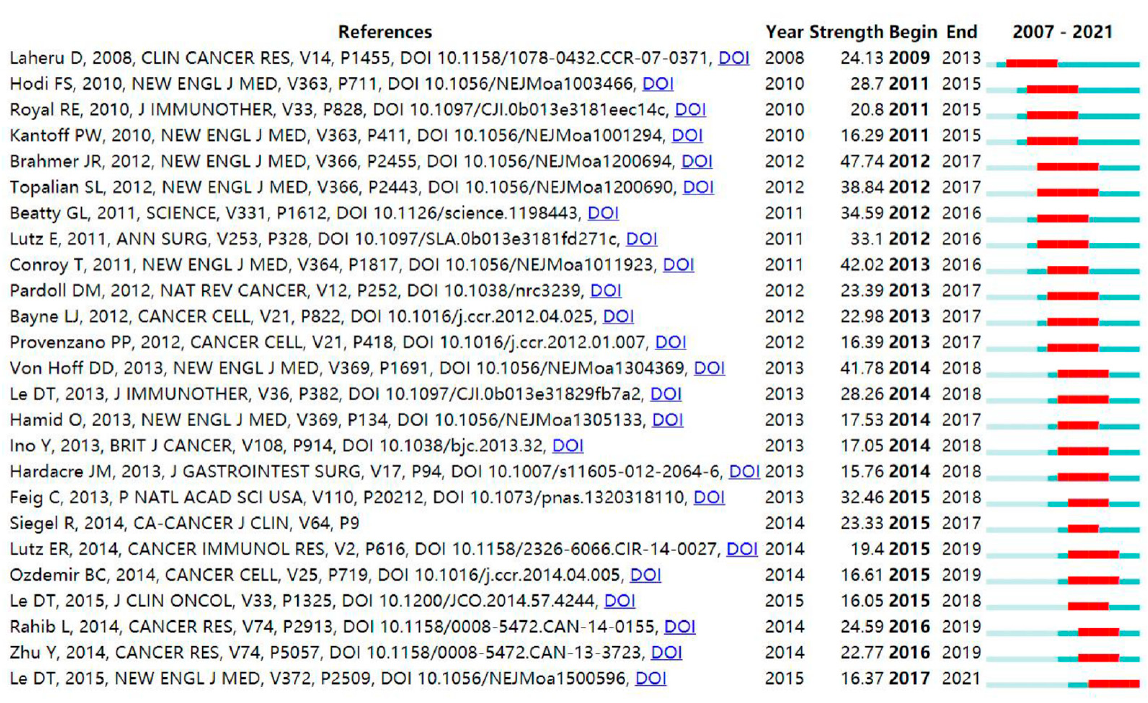
Figure 7. The top 25 references with the strongest citation bursts during 2007 to 2021.